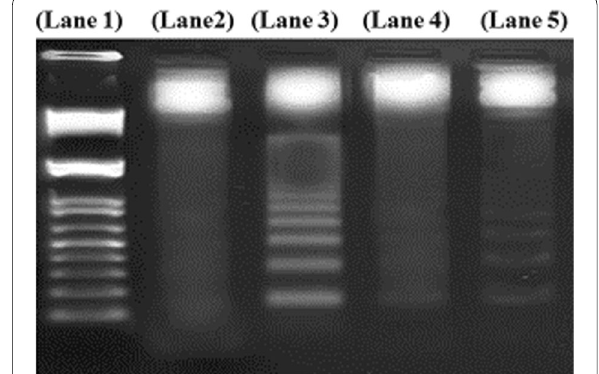
Fig. 2 DNA fragmentation in HepG2 and HCT‑116 cells treated with NSP for 48 h; lane 1: DNA laddering, lane 2: HepG2 untreated control cells, lane 3: HepG2 treated cells, Lane 4: HCT‑116 untreated